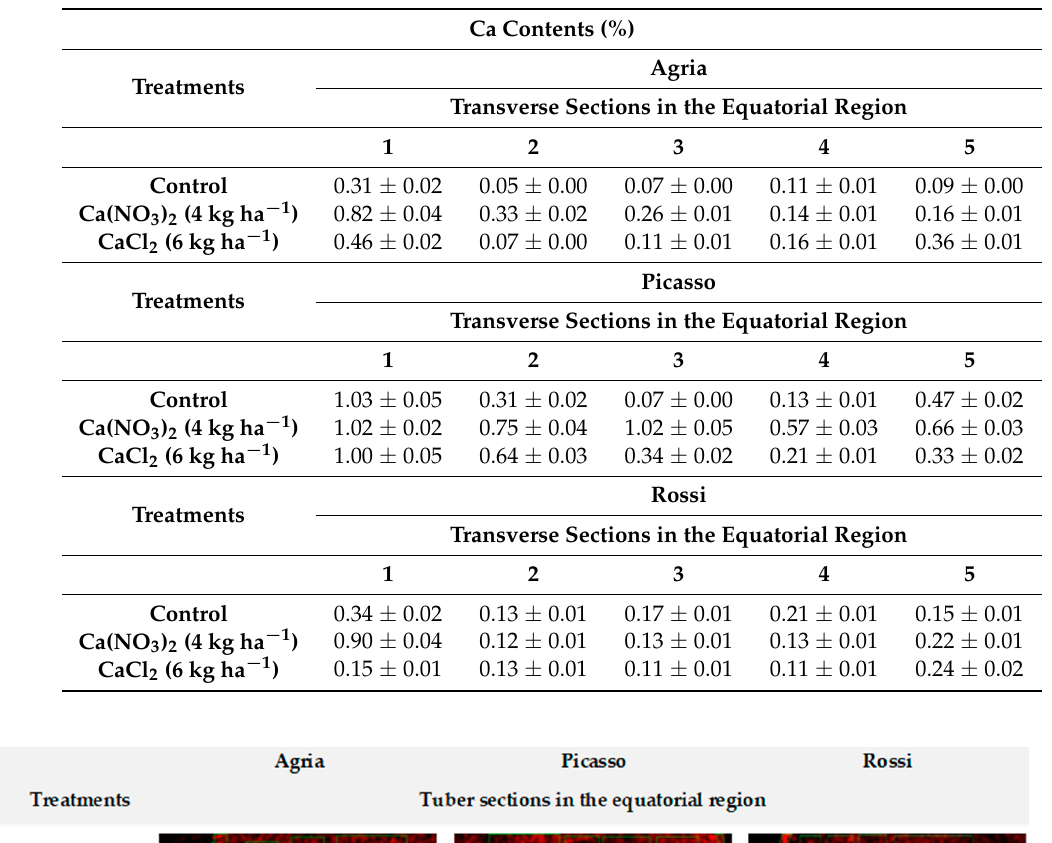
Table 3. Average of Ca contents ± S.E. ( n = 4) in 5 transverse sections of the equatorial region (ranging from the epidermis to the center, 1–5), of tubers of Solanum tuberosum L., varieties Agria, Picasso and Rossi, obtained at harvest (control and treated plants with 4 kg.ha − 1 Ca(NO 3 ) 2 and 6 kg.ha − 1 CaCl 2 ). Control was not sprayed with Ca(NO 3 ) 2 or CaCl 2 .